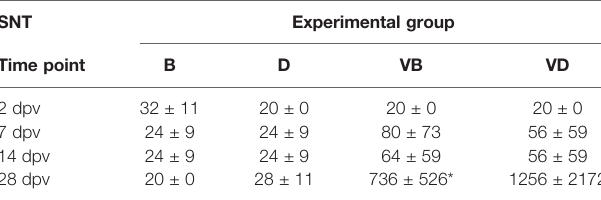
The description of experimental groups: B – BSA non-vaccinated, D – defensins non- vaccinated,VB-BSAvaccinated,VD – defensinsvaccinated.Theresultsarepresentedas a mean ± SD of the highest serum dilution inactivating the CyHV-3. * indicates statistical signi fi cant difference when compared with the control at p < 0.05. Statistical analysis